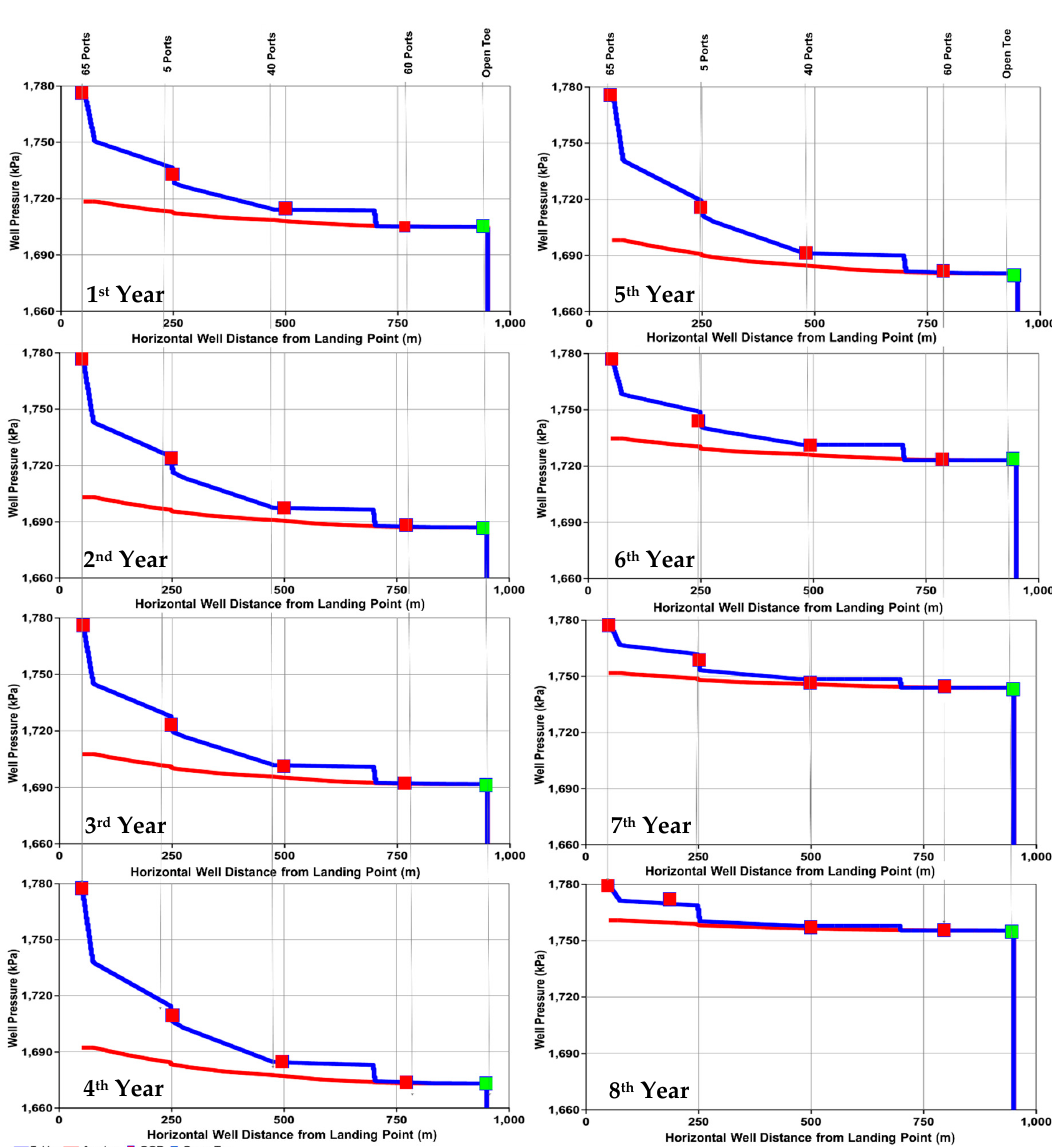
/ annulus pressure